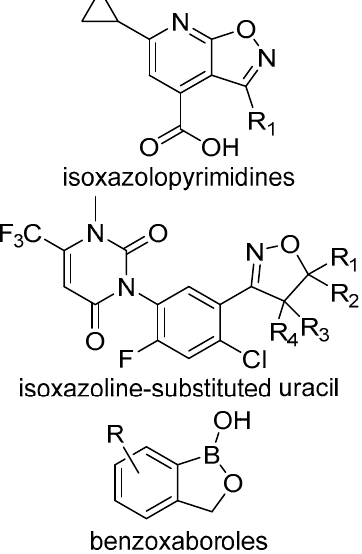
Figure 16. Structural features of the chemical classes mentioned in Section 4.